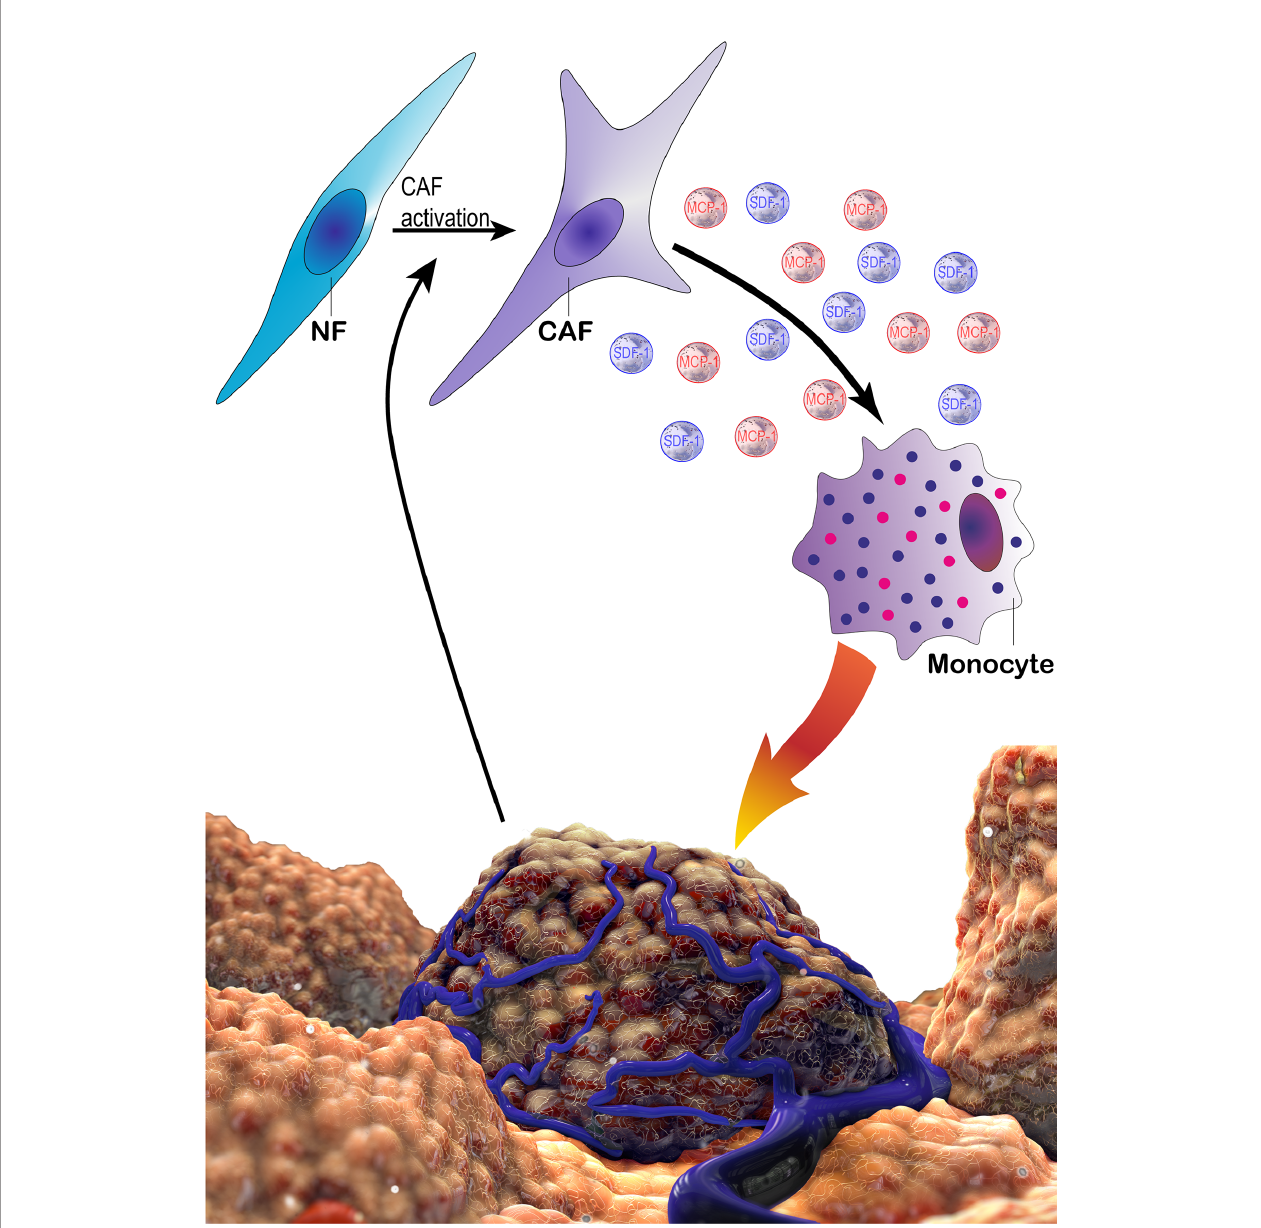
FIGURE 11 | The schematic demonstration of potential tri-directional interactions of cancer cells, CAFs and monocytes. Cancer cells can take part in the activation of CAFs via several factors. CAFs may in turn recruit monocytes via MCP-1 and SDF-1. In addition, CAFs promote a pro-tumoral phenotype in monocytes/ macrophages, which enhance cancer cell proliferation and motility as well as suppressing immune responses. CAF, cancer associated fi broblast; MCP-1, monocyte chemotactic protein-1; NF, normal fi broblast; SDF-1, stromal derived factor